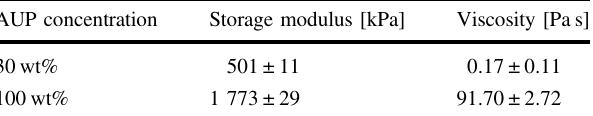
Table 2 Overview of the measured storage moduli and viscosity for various AUP concentrations as obtained using rheology and in situ UV crosslinking